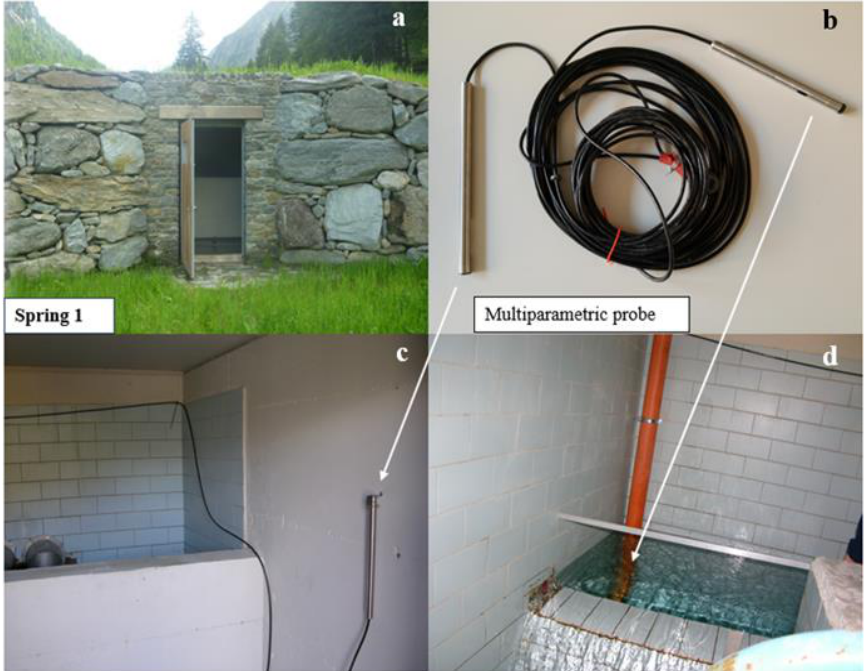
Figure 3. Mascognaz 1 spring’s structure and set up: ( a ) External view of the spring water intake structure; ( b ) Multiparametric probe geometry; ( c ) Installation of probe data logger; ( d ) Installation of recording probe .